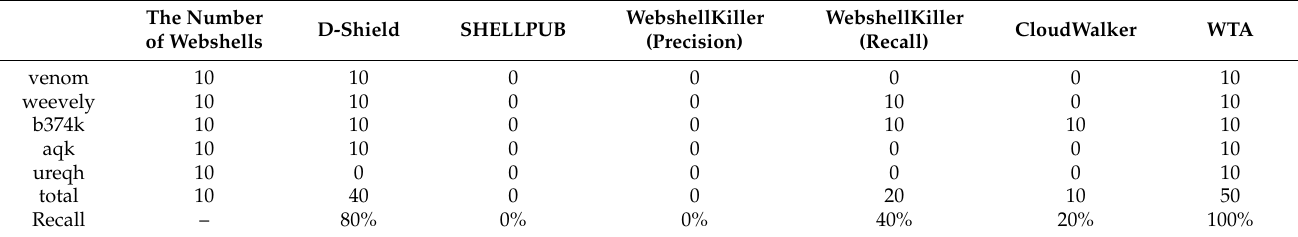
Table 9. The detection effect for unknown